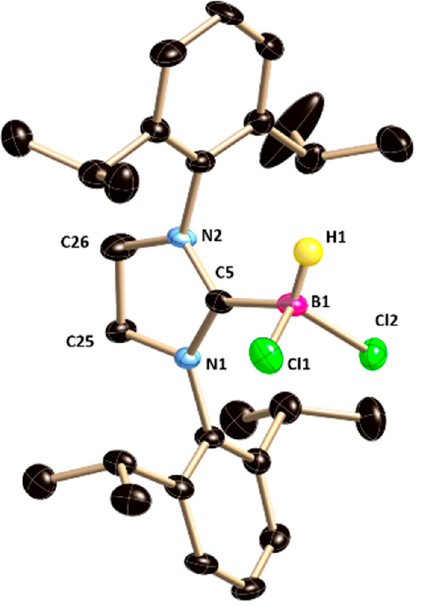
Figure 1. The molecular structure of 1 (hydrogen atoms except at the boron atom in 1 are omitted for clarity). Selected bond lengths [Å] or angles [deg]: C5–N1 1.337(5), C5–N2 1.329(6), C25–N1